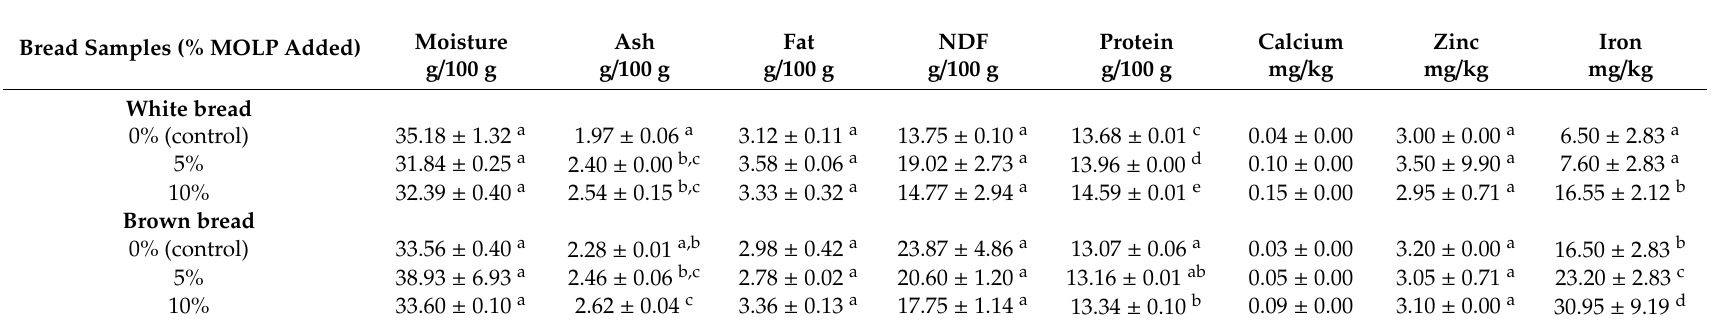
Table 3. Nutritional composition of white and brown breads containing di ff erent concentrations of Moringa oleifera leaf powder (MOLP) on a dry weight basis (DW)].